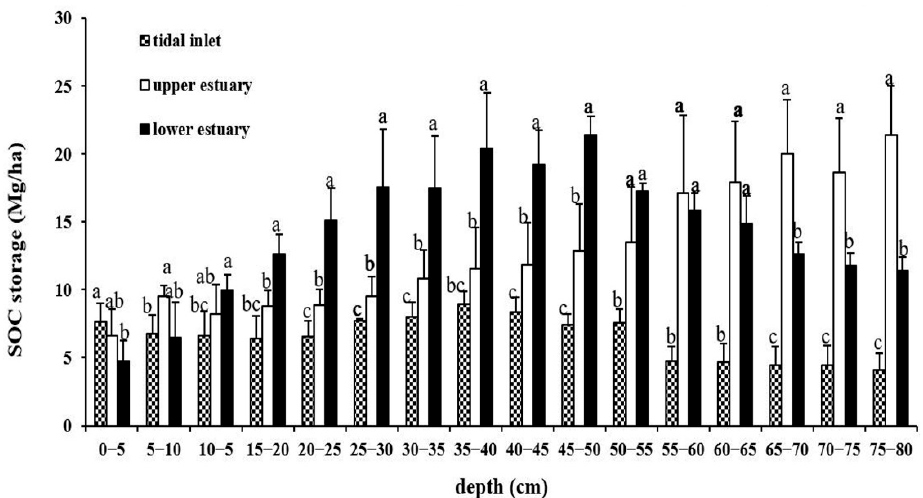
Figure 3. SOC storage of various soil layers (5 cm) in three geomorphologic settings. Different lowercase letters indicate significances among sites at the same soil layer ( p < 0.05).